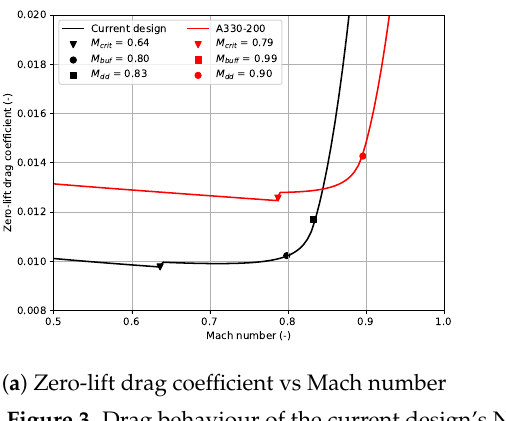
Figure 3. Drag behaviour of the current design’s NACA 63(3)-418 NLF airfoil and the NASA SC(2)- 0414 supercritical airfoil used to model the